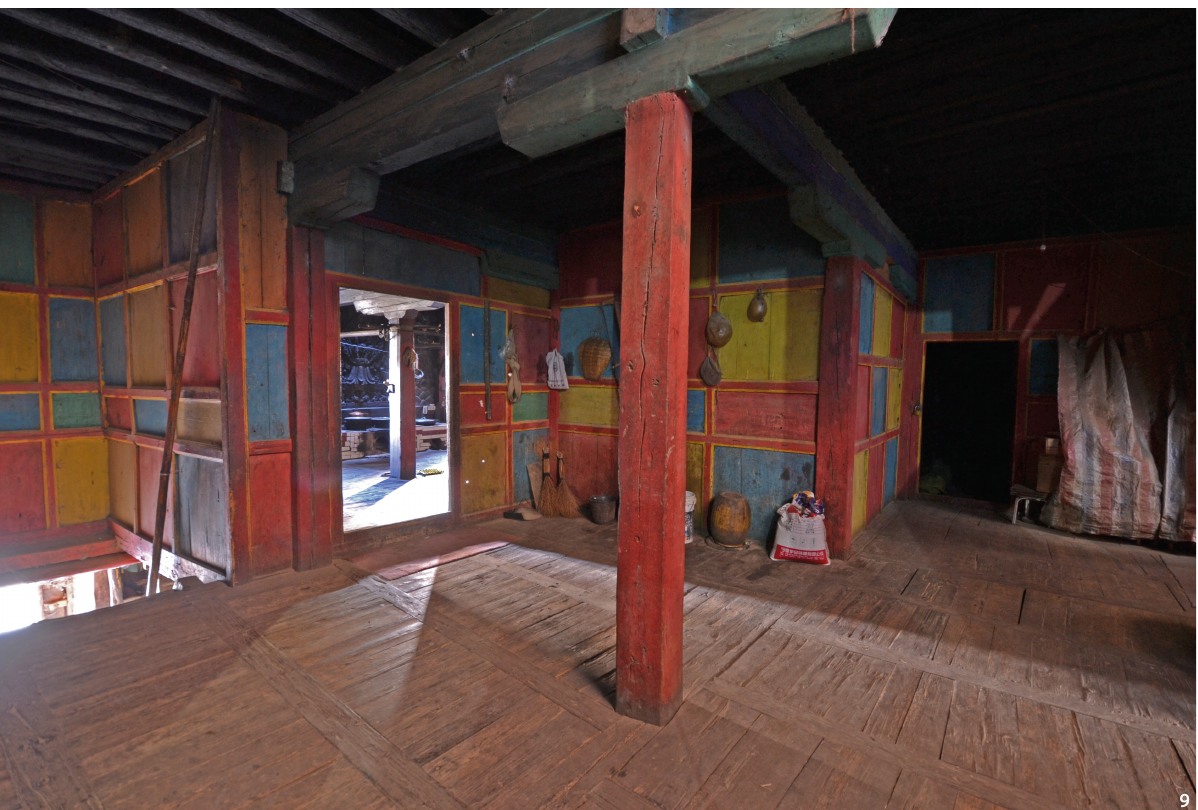
Figure 9 Interior of central hall of the farmhouse in Chatreng (Source: the